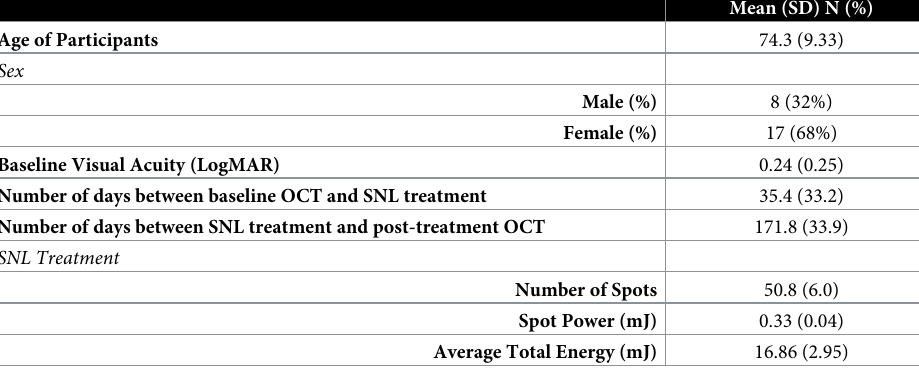
Table 1. Characteristics of study participants and details of SNL treatment.